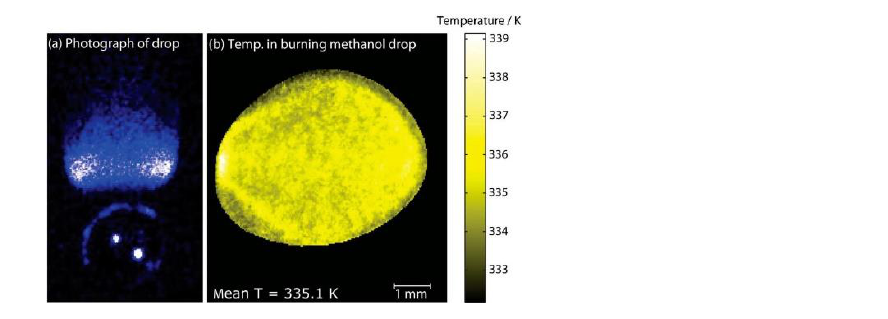
Figure 24. ( a ) A falling, burning methanol droplet photographed by an ICCD camera without filters; ( b ) a temperature image of a free-falling methanol droplet burning in the middle of the Bunsen burner [96]. Reprinted with permission from [96]. Optica Publishing Group, 2008.